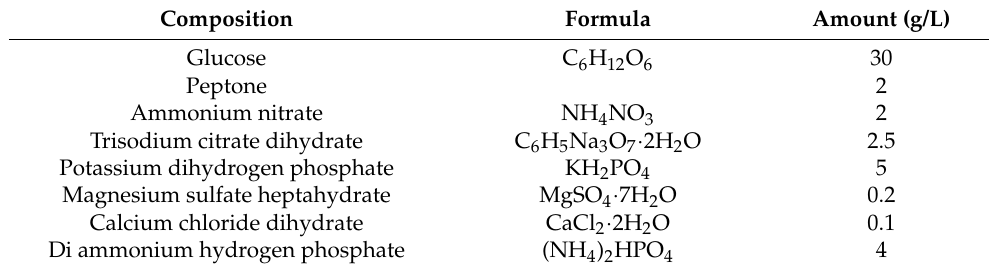
Table 2. Nutrient-mineral salt